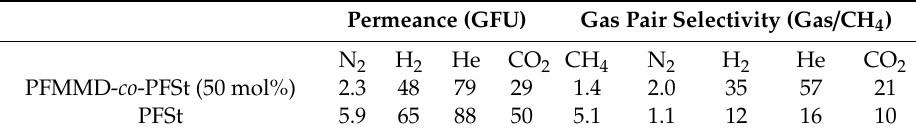
Figure 10. Effect of feed pressure on the pure gas permeability of the film (50 mol% PFSt). Table 8. Gas transport properties of PFMMD- co -PFSt (50mol%) at 50 psig and 35 °C [34,36].